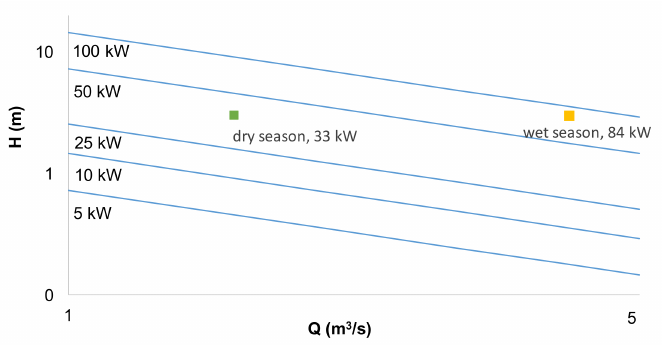
Figure 6. Curves for potential hydraulic power recovering ( η = 70%).